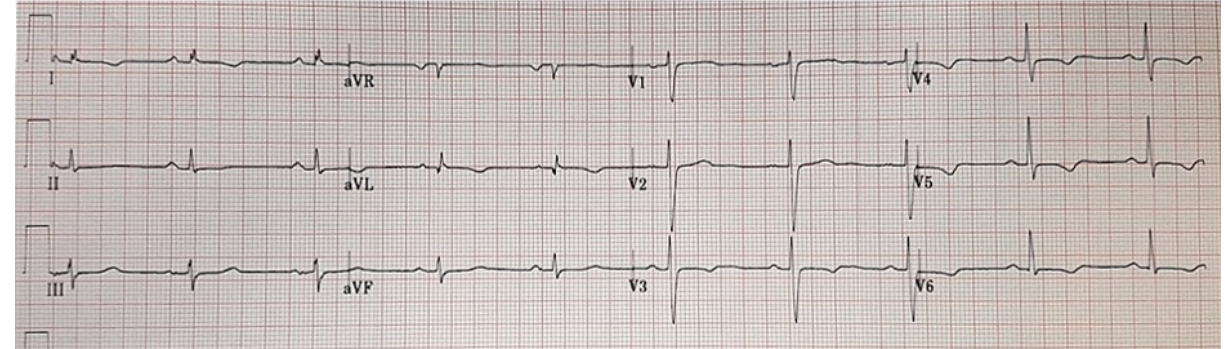
Figure 1. Electrocardiographic features of a patient affected by left-dominant arrhythmogenic cardiomyopathy. Basal electrocardiogram characterized by low QRS voltages in limb leads and negative T-waves in the lateral leads.